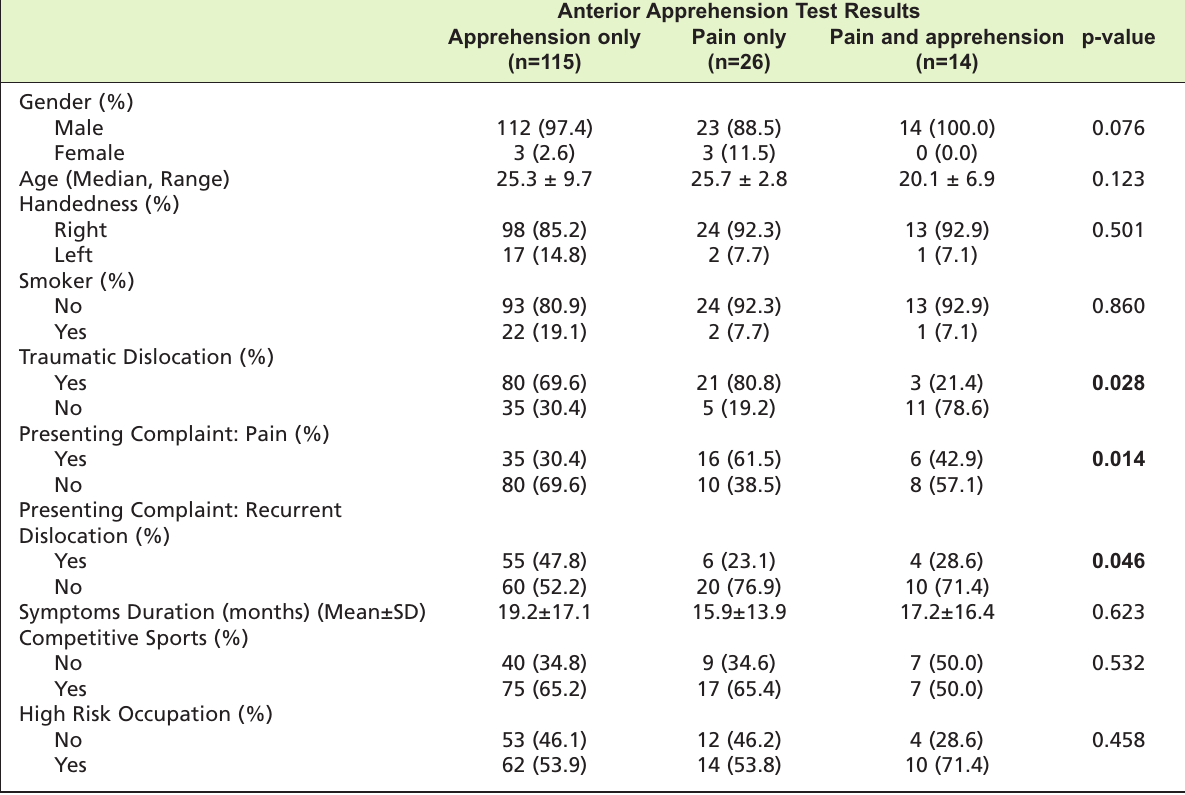
Patient profile, demographics and clinical characteristics Table I: Anterior Apprehension Test Results